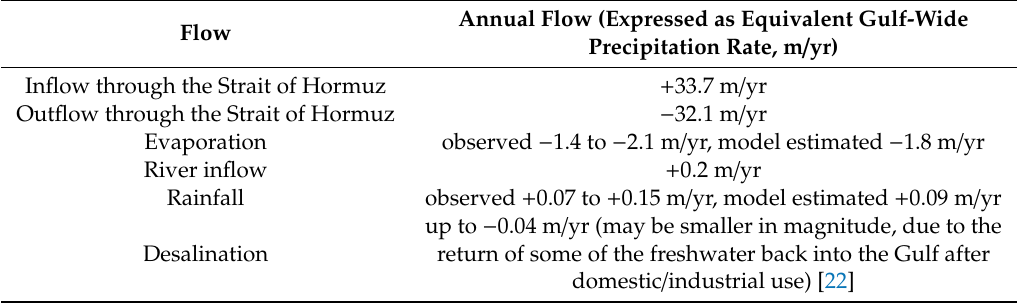
Table 1. Gulf water balance (Based on [21]).